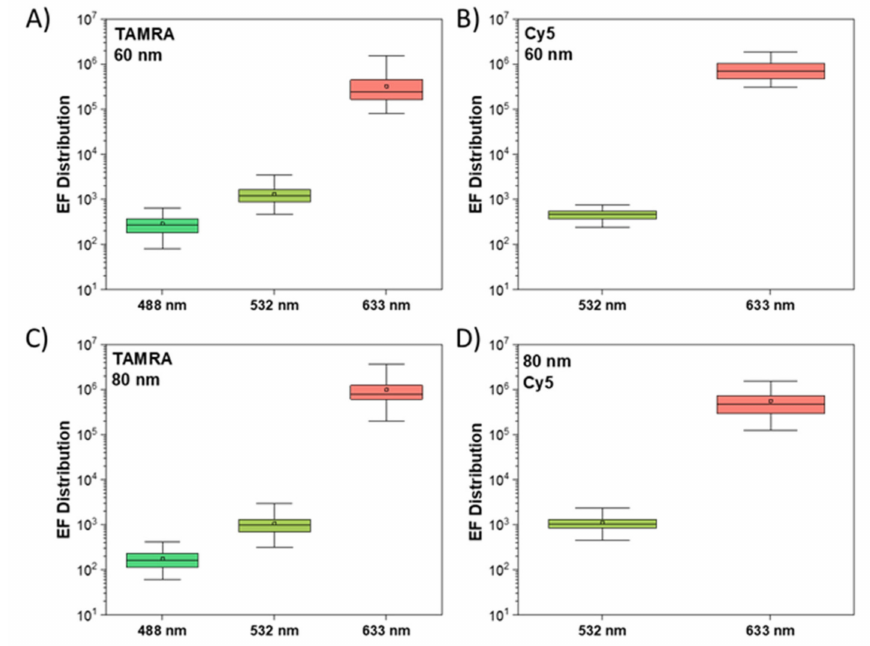
Figure 6. EF distribution box plots. ( A , B ) EF obtained for the dimers containing 60 nm AuNP modified with TAMRA and Cy5 respectively. ( C , D ) EF obtained for the dimers containing 80 nm AuNP modified with TAMRA and Cy5